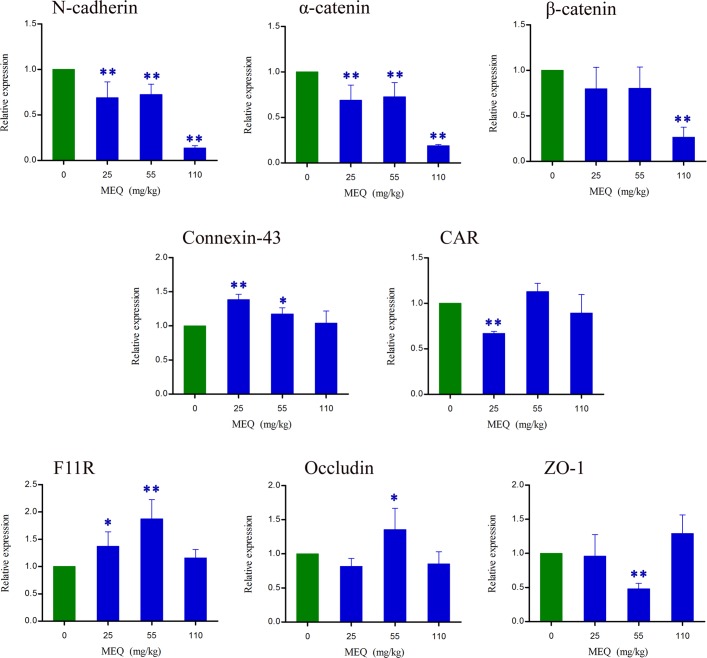
Alterations of N-cadherin, α-catenin, β-catenin, Connexin-43, CAR, F11R, Occludin and ZO-1 expression in mouse testes after the administration of MEQ for 18 months. ∗p < 0.05 in comparison with control, and ∗∗p < 0.01 in comparison with control. Values represent means ± SD (n = 10).